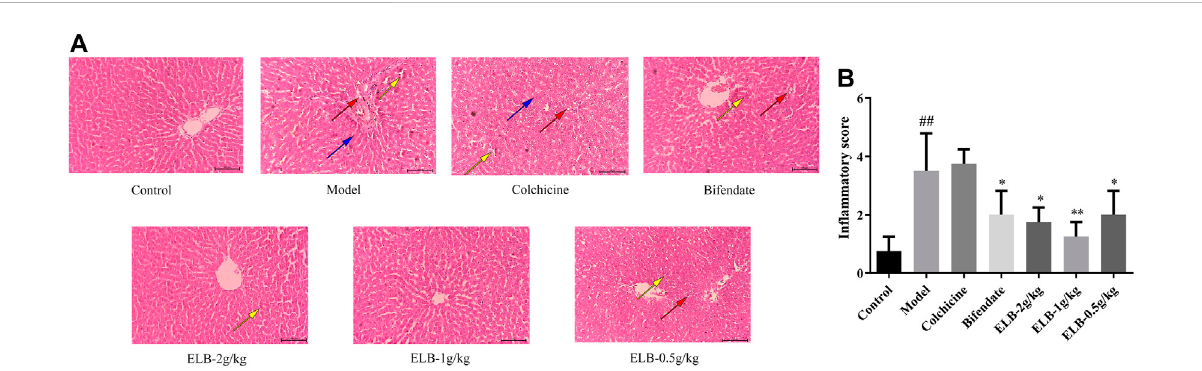
FIGURE 2 Histopathological evaluation showing the effects of ELB on liver tissue in rats with chronic alcoholic liver injury and gouty arthritis. Representative images (A) . Histopathological quantitative score (B) . The red arrow indicates fat vacuoles, yellow arrow indicates eosinophilic degeneration, blue arrow indicates disappearance of the